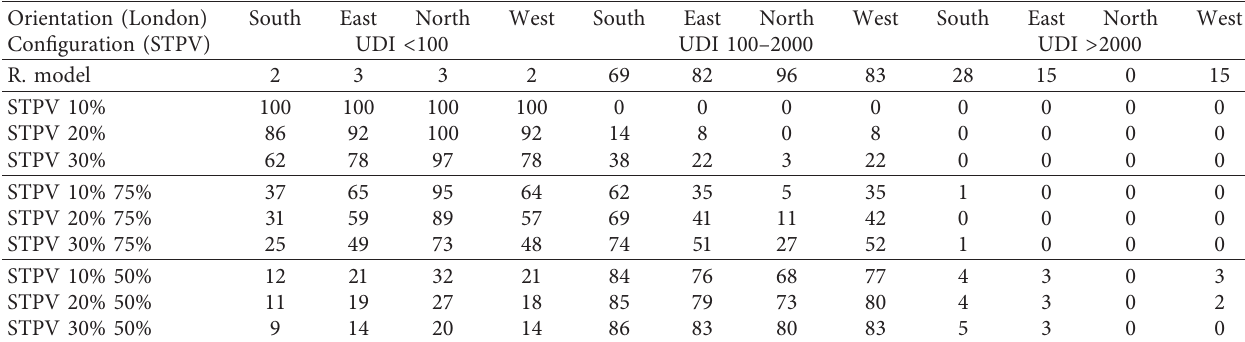
Table 14: UDI thresholds in cardinal orientations under overcast sky condition (London city).